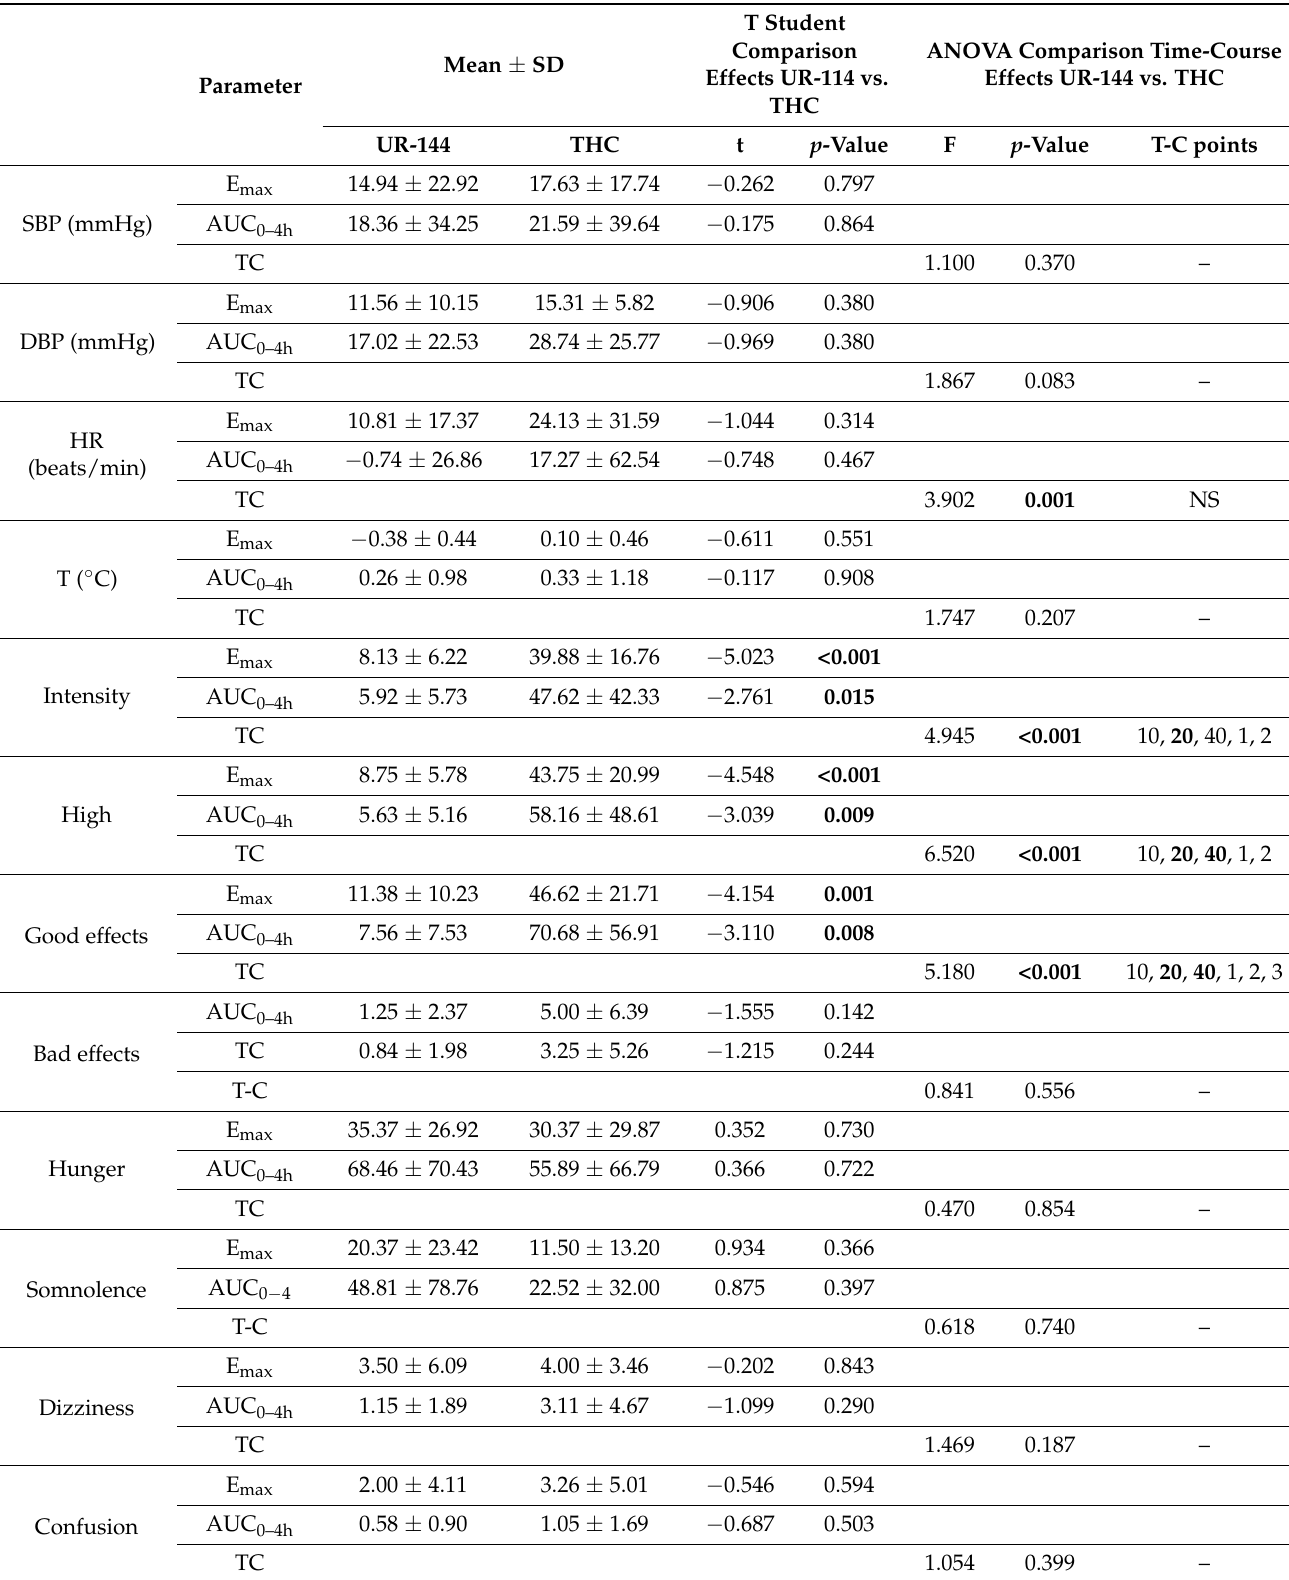
Table 1. Summary of significant statistical result on acute physiological and subjective effects observed after administration of UR-144 ( n = 8) and cannabis ( n =